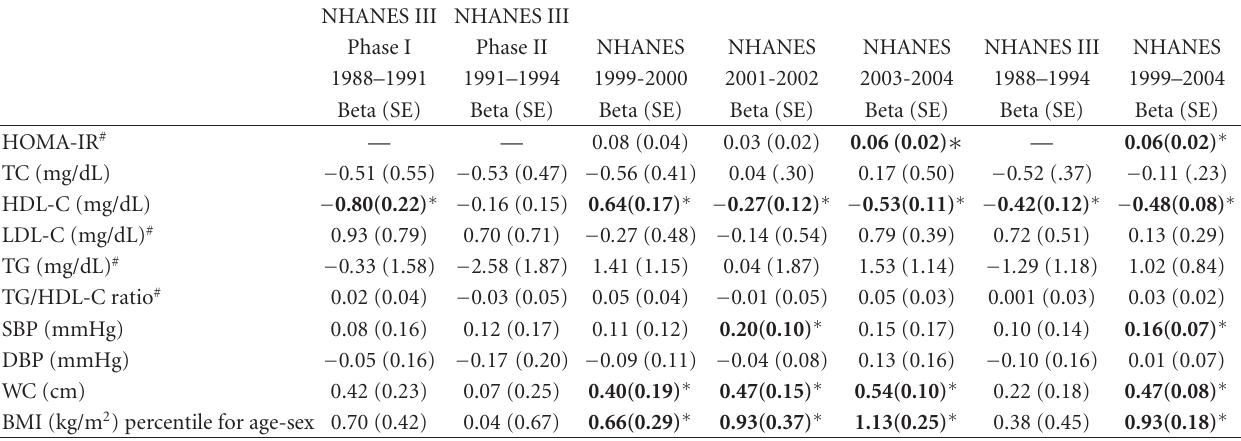
Table 4: Regression analyses of metabolic parameters and anthropometric Measurements associated with SSB intake among US adolescents aged 12–19 years: NHANES III (1988–1994), NHANES 1999-2000, NHANES 2001-2002, NHANES 2003-2004, and complete NHANES 1999–2004 cohorts. Beta (SE) represents the number of SSBs consumed per day, adjusting for amount of physical activity performed per day, age, sex, ethnicity, and energy intake per day (in kilocalories). Abbreviations: HOMA-IR, homeostasis model assessment of insulin resistance; TC, total cholesterol; TG, triglyceride; HDL-C, high-density lipoprotein cholesterol; LDL-C, low-density lipoprotein